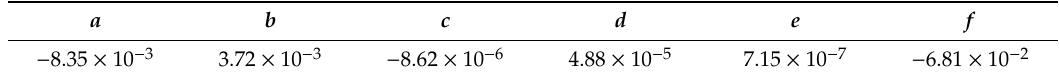
Table 2. Coe ffi cients required to obtain the winter severity index ( WSI )